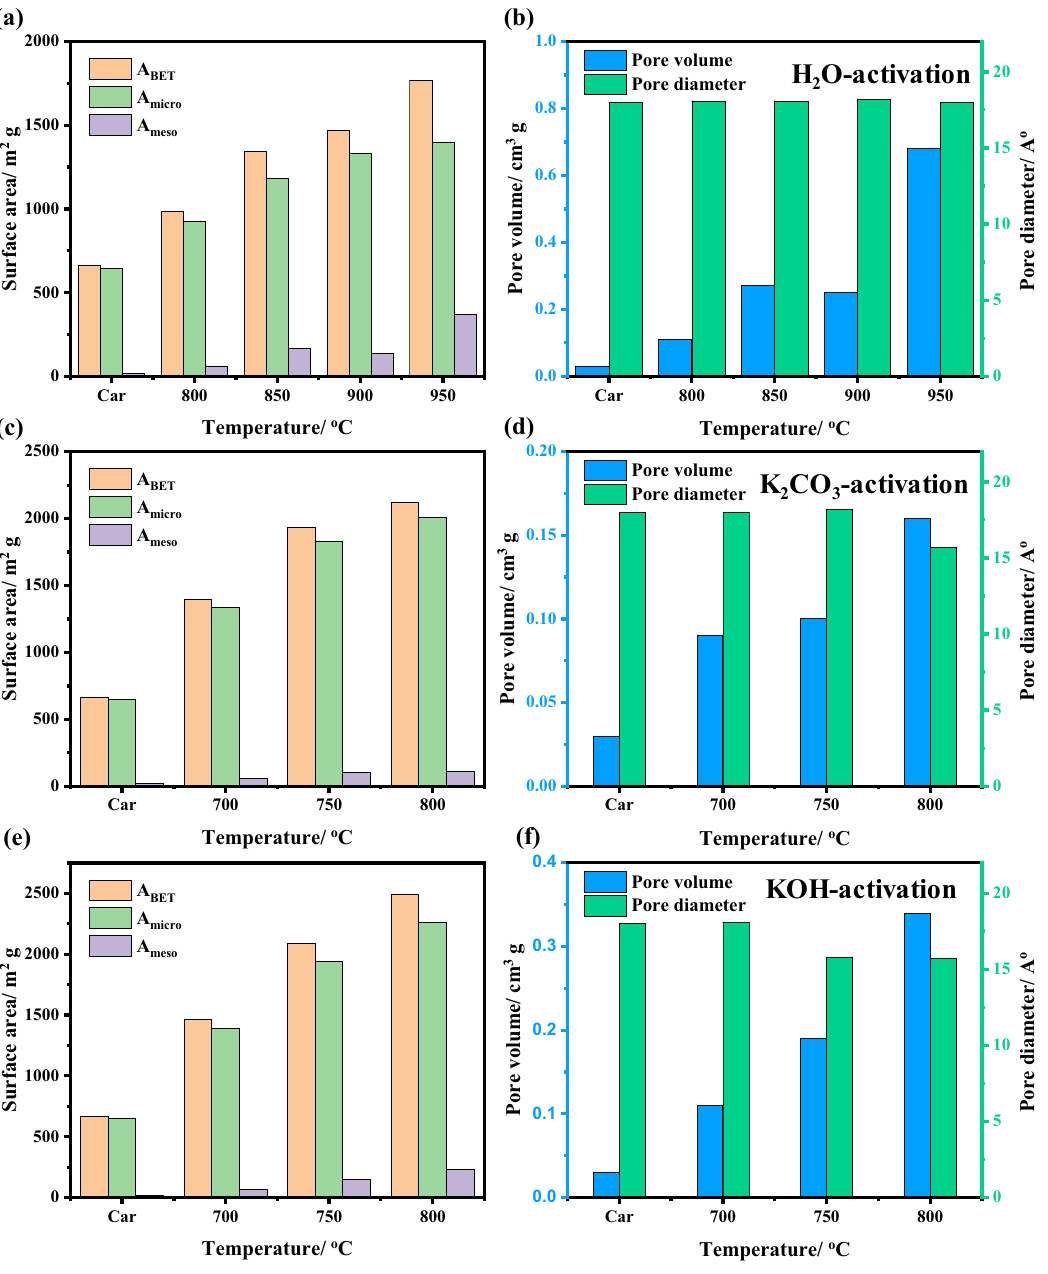
Figure 6. Specific surface areas, pore volume, and pore diameter of BU-car sample activated with various activators, water vapor ( a , b ), K 2 CO 3 ( c , d ), and KOH ( e , f ), at different